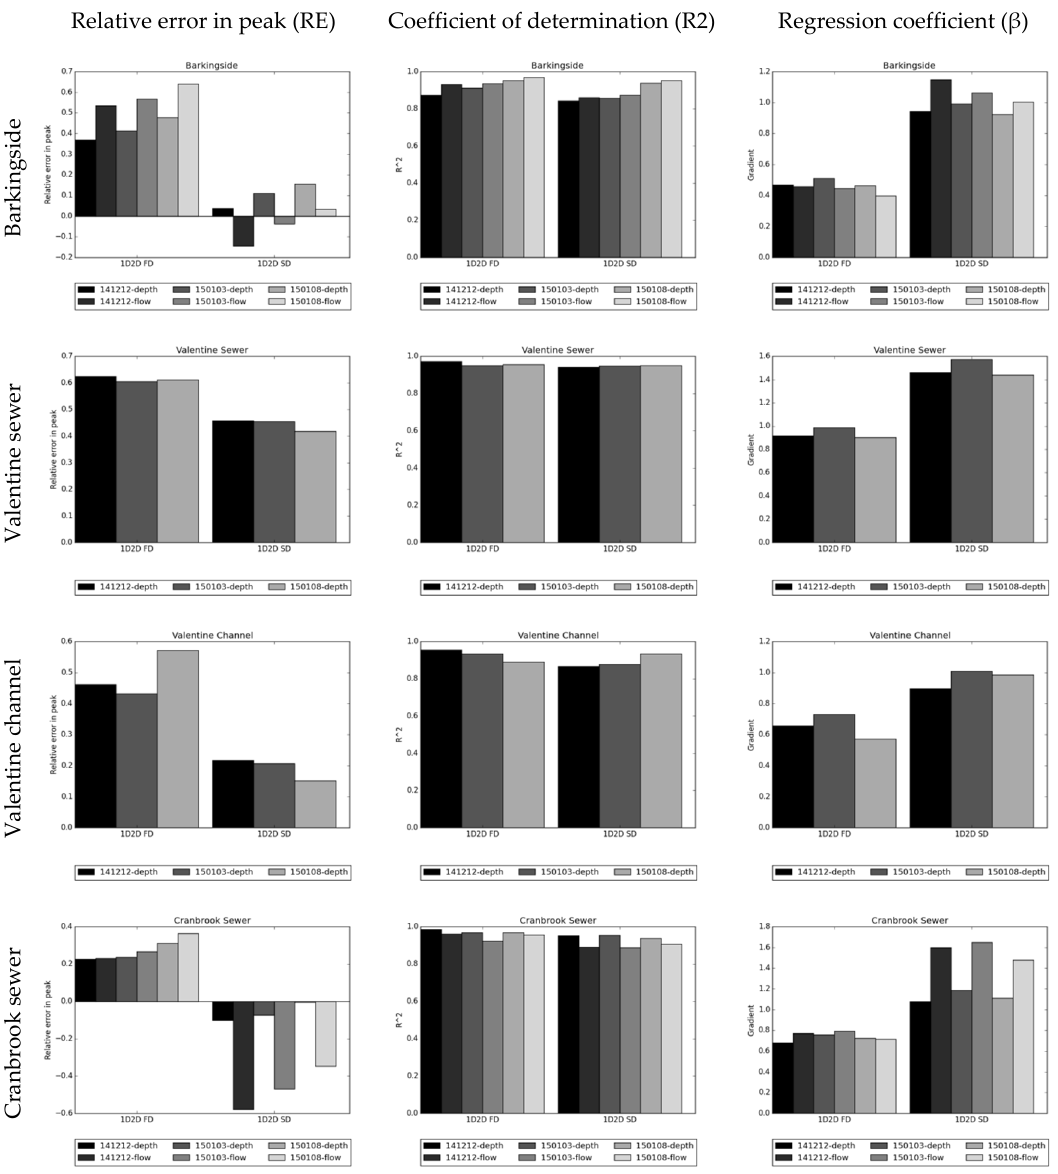
Figure 10. Statistical analysis of modeling results against observed data of Cranbrook case study.